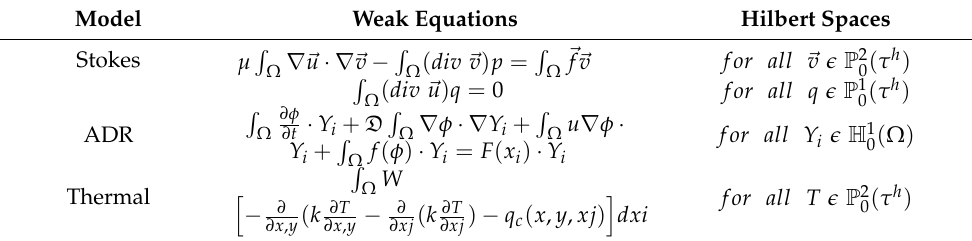
Figure 2. ( left ) geometric characteristics and boundary values; ( right ) dicretization of the domains. Table 1. Scheme of the weak equations used in the model, where (cid:126) v , q , Y i , W are the smooth functions and H 1 , P 1 , P 2 are the Hilbert 0 0 0